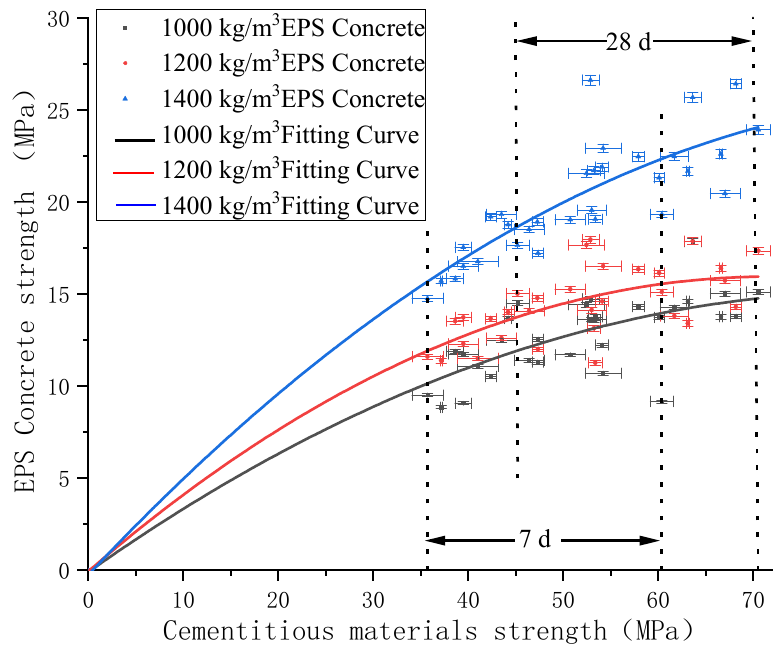
Figure 3. Fitting diagram of the effect of paste strength on EPS-concrete strength. The paste strength of the 1000 kg/m 3 , 1200 kg/m 3 , and 1400 kg/m 3 of EPS concrete was fitted with the power function for the strength of EPS concrete. The fitting curves with different densities are shown in Figure 3. It can be seen from the figure that, with the increase in density, the high-density fitting curve is above the low-density fitting curve. The EPS-concrete fitting curve of the 1000 kg/m 3 and 1200 kg/m 3 EPS concrete is smoother than that of the 1400 kg/m 3 concrete. Therefore, when the density of EPS concrete is lower than 1000 kg/m 3 , the extreme value of the curve will continue to decrease and will become smooth earlier. When the density of EPS concrete is higher than 1400 kg/m 3 , the